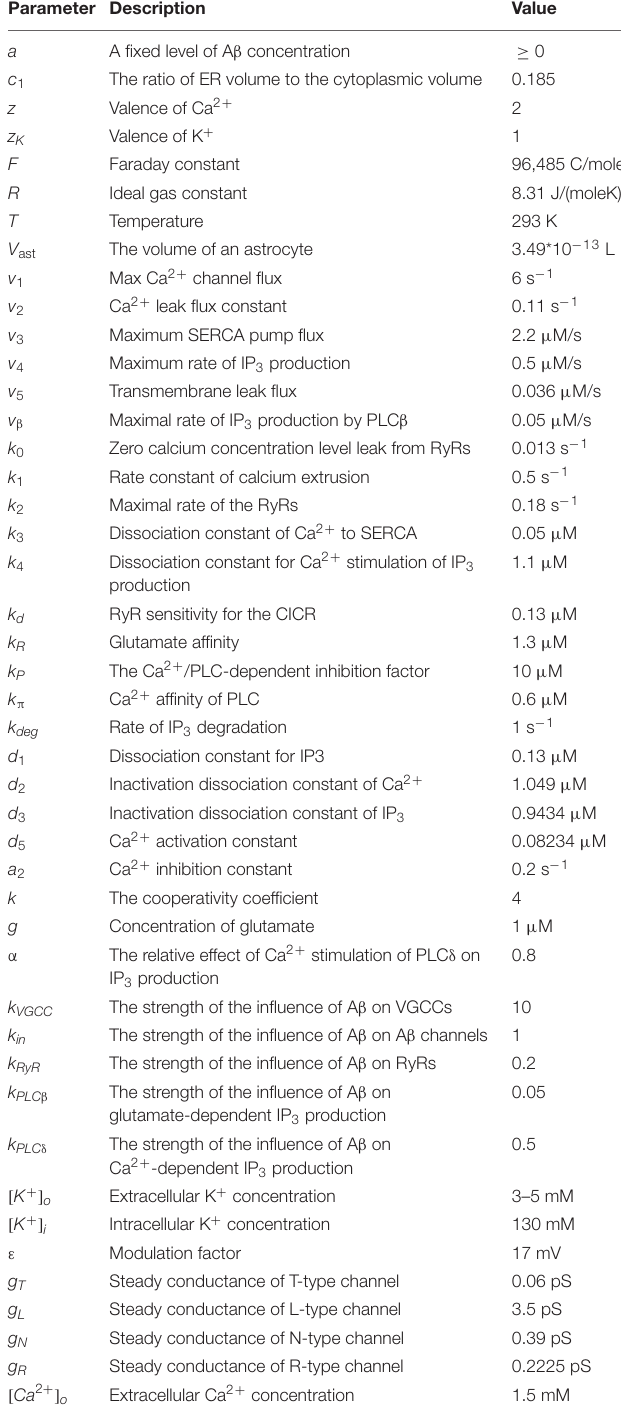
TABLE 2 | Parameters used in the